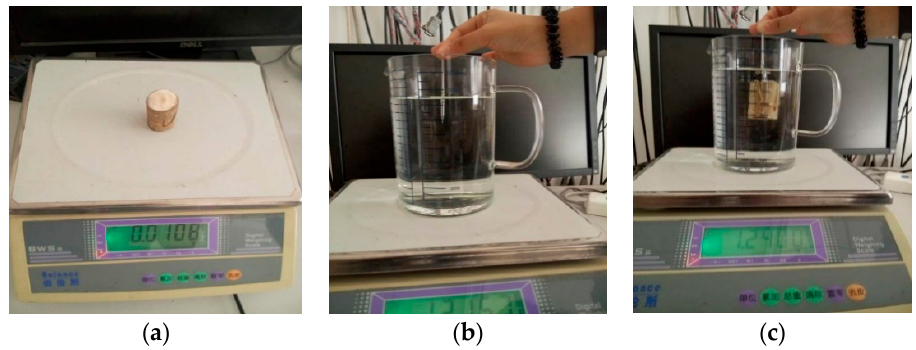
Figure 5. Density measurement for a 50-mm-long specimen: ( a ) the mass of m , ( b ) the mass of m 0 , ( c ) the mass of m 1 .